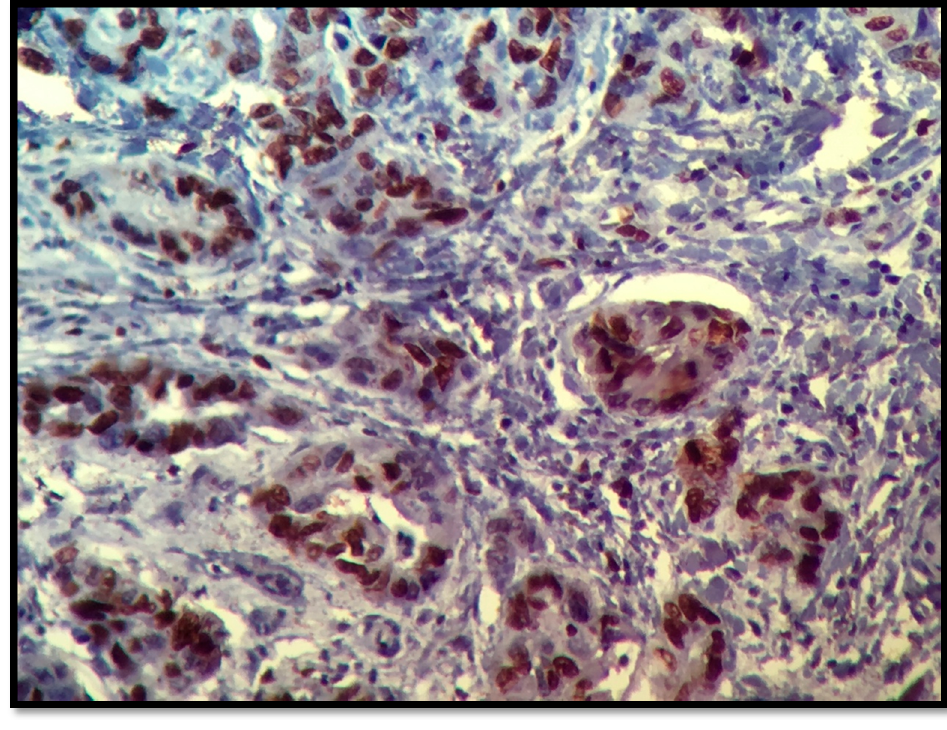
Figure 3. ER, 40 × , 80%. Figure 3. ER, 40×, 80%. Figure 3. ER, 40×, 80%.